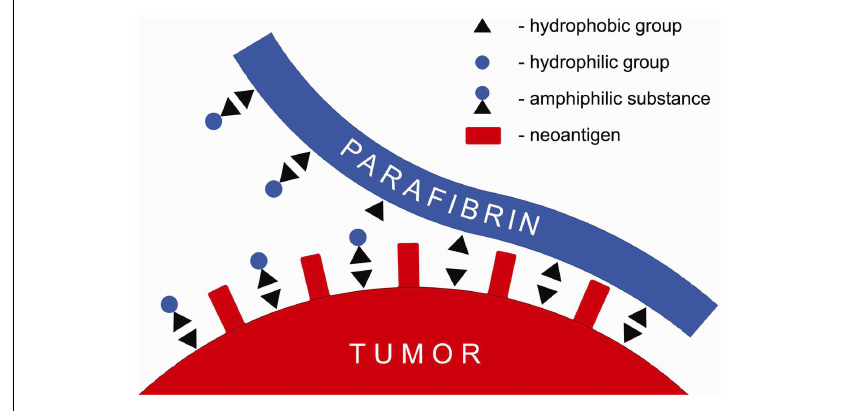
FIGURE 1 | Schematic presentation of a putative mechanism of the anticancer effect of amphiphilic substances that displace parafibrin from surface of the cancer cell membrane